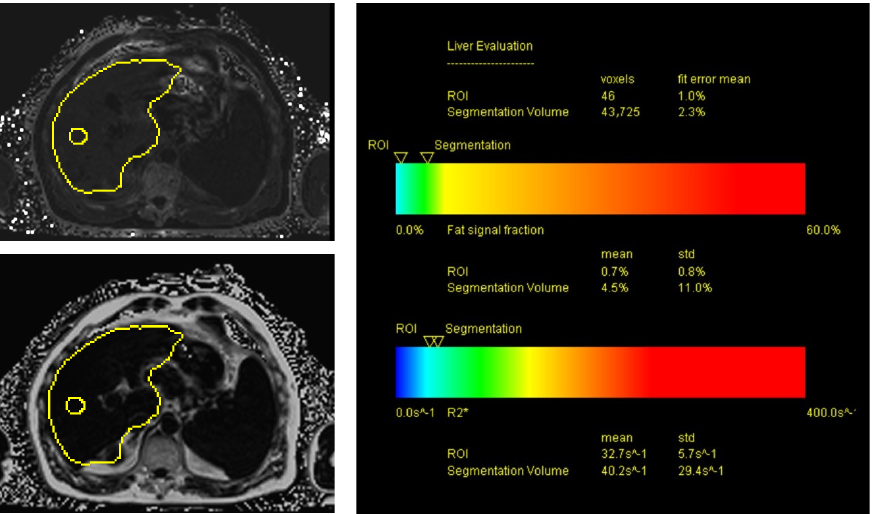
Figure 3. MRI PDFF sequences in axial view of a patient with known liver cirrhosis. The fat signal fraction inside the positioned ROI (see yellow ROI in left images) showed mean values <5%, consistent with no evidence of hepatic steatosis.